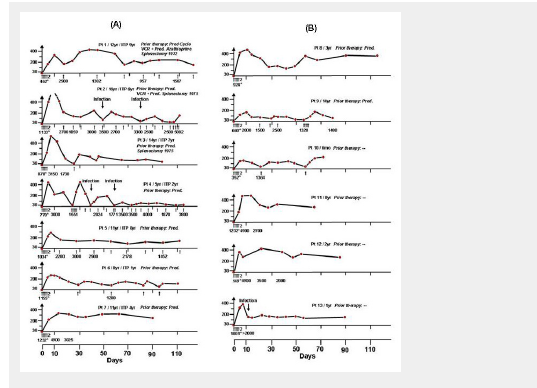
Pilotstudy 2: (A) 7 patients with chronic or intermittent ITP, (B) 6 patients with newly diagnosed ITP. All, consecutive patients with primary ITP demonstrated increases of platelet counts. Arrows indicate IVIG 0,4 g/kg body weight/day (© Imbach P, Barandun S, d’Apuzzo V, Baumgartner C, Hirt A, Morell A, et al. High-dose intravenous gammaglobulin for idiopathic thrombocytopenic purpura in childhood. Lancet. 1981;1:1228–31. Reprinted with kind